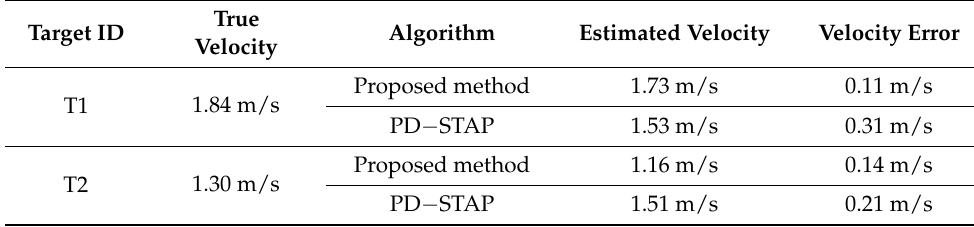
Figure 13. Velocity estimation function P out of T2: ( a ) the proposed method; ( b ) PD − STAP. Table 2. Target radial velocity